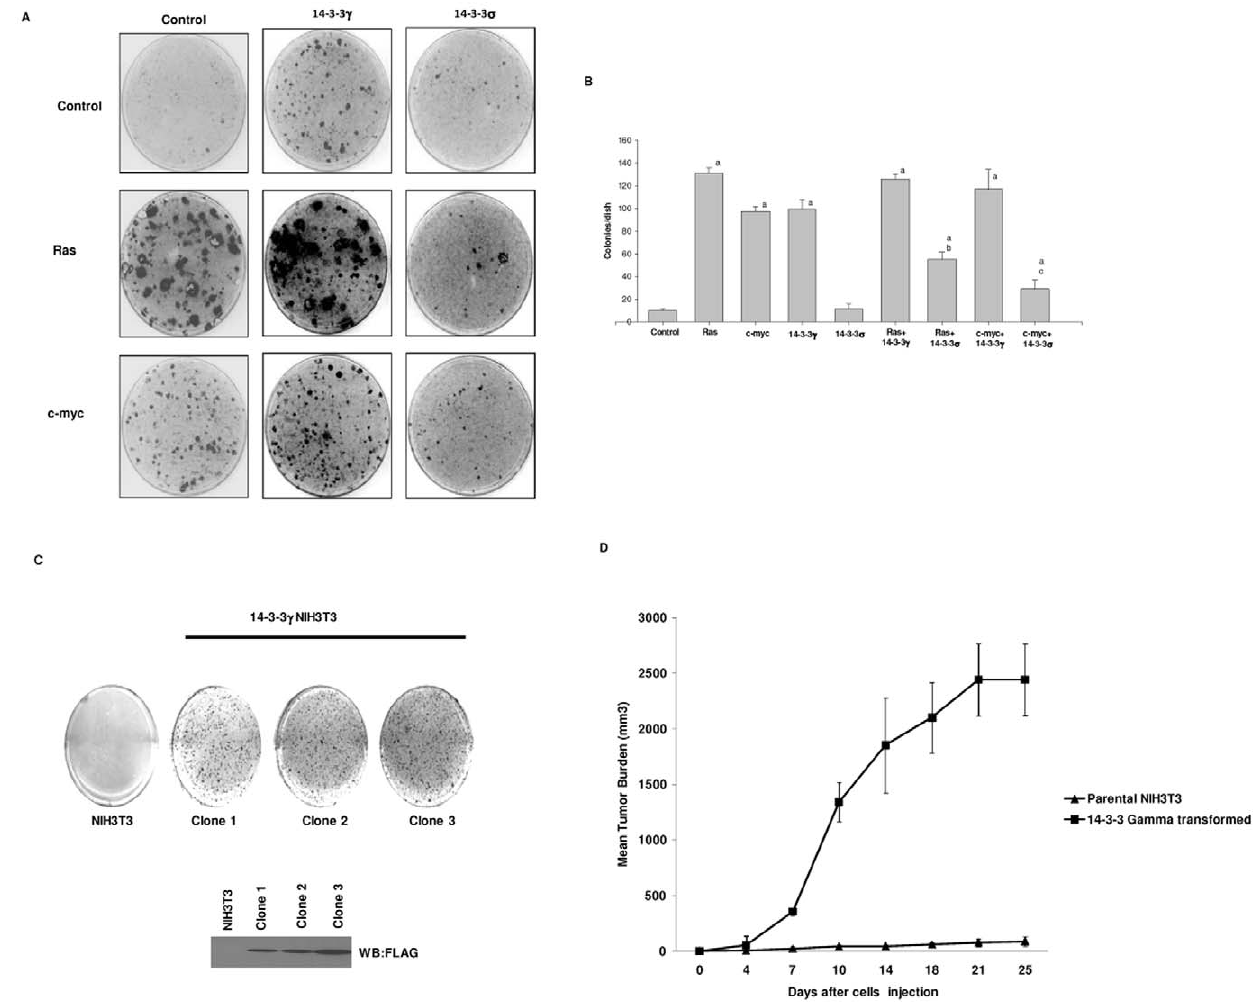
Figure 1. 14-3-3 c , but not 14-3-3 s , induces focus formation in NIH3T3 cells. (A) H-ras, c-myc, 14-3-3 c and 14-3-3 s expression plasmids were transfected into NIH3T3 cells as described in the methods section, replated 48 h after transfection and maintained for an additional 21 days. Subsequently, the cells were stained with crystal violet and the number of foci quantified using an Oxford Optronix colony counter, UK. The experiment was repeated twice. A typical experiment is depicted. (B) The number of foci in panel A was determined and graphed. Bars depict the average number of foci per dish. (a, p , 0.05 vs control; b, p , 0.05 vs H-ras; c, p , 0.05 vs c-myc, Student’s t-test). (C) Several 14-3-3 c transformed foci from the experiment in panel A were collected and tested for growth in soft agar. Twenty one days after seeding, the colonies were stained. The growth of parental NIH3T3 cells is shown for comparison. (D) One of the clones from panel C was injected into eight SCID mice at 1 6 10 7 cells per injection. Tumor volume was measured every 3–4 days for a total of 25 days. For comparison, NIH3T3 cells were injected into SCID mice as a control.